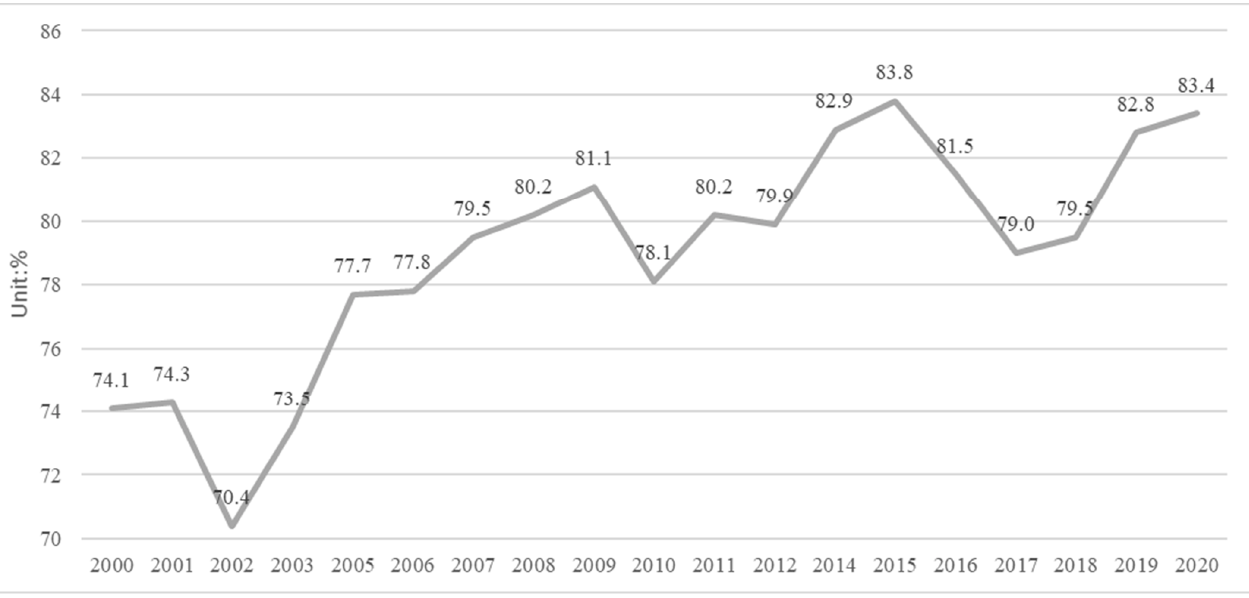
Figure 2. Asset–liability ratio of real estate development enterprises in Guizhou Province from 2000 to 2020.